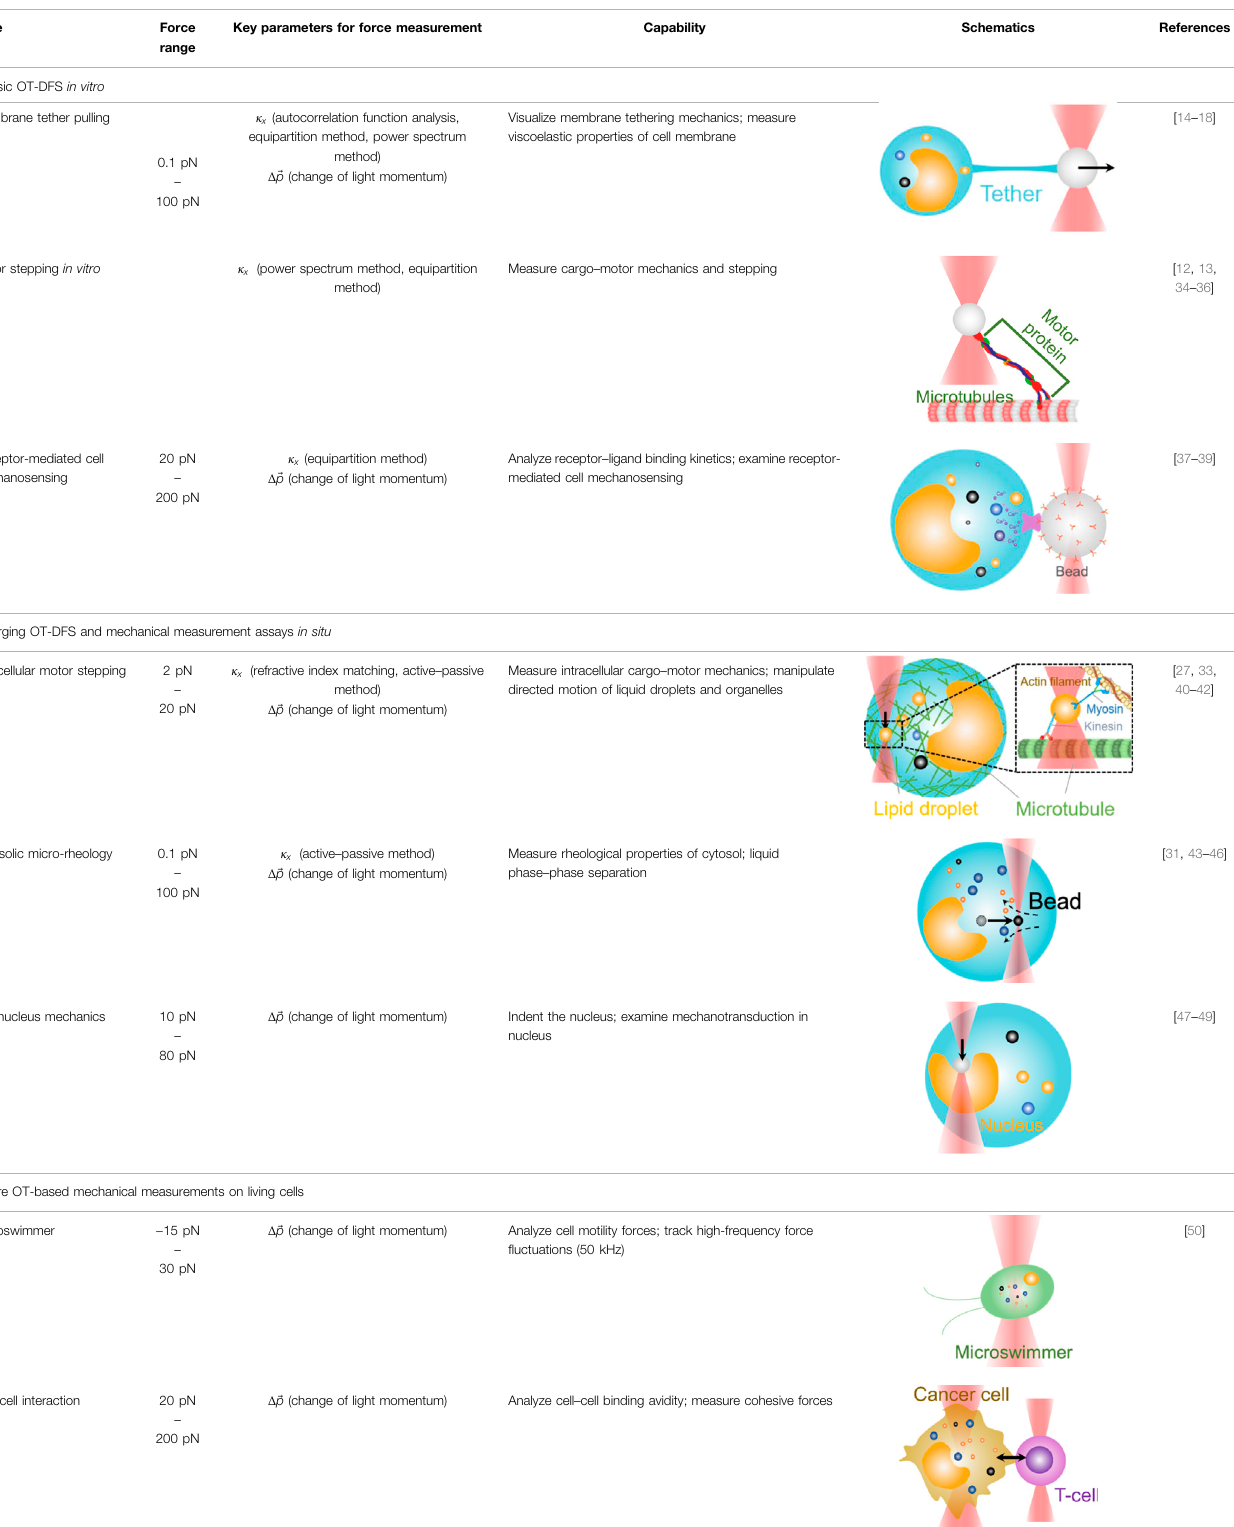
TABLE 1 | Optical tweezers force spectroscopies and applications from extracellular to intracellular space.